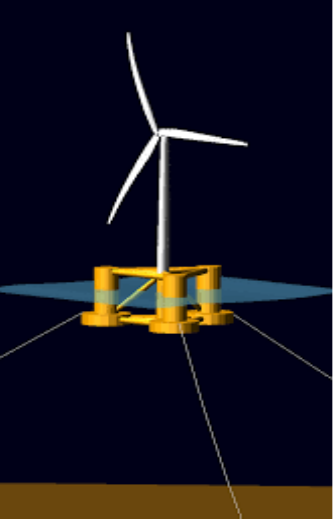
Figure 2. Structure of the wind turbine and platform. Source: [12].